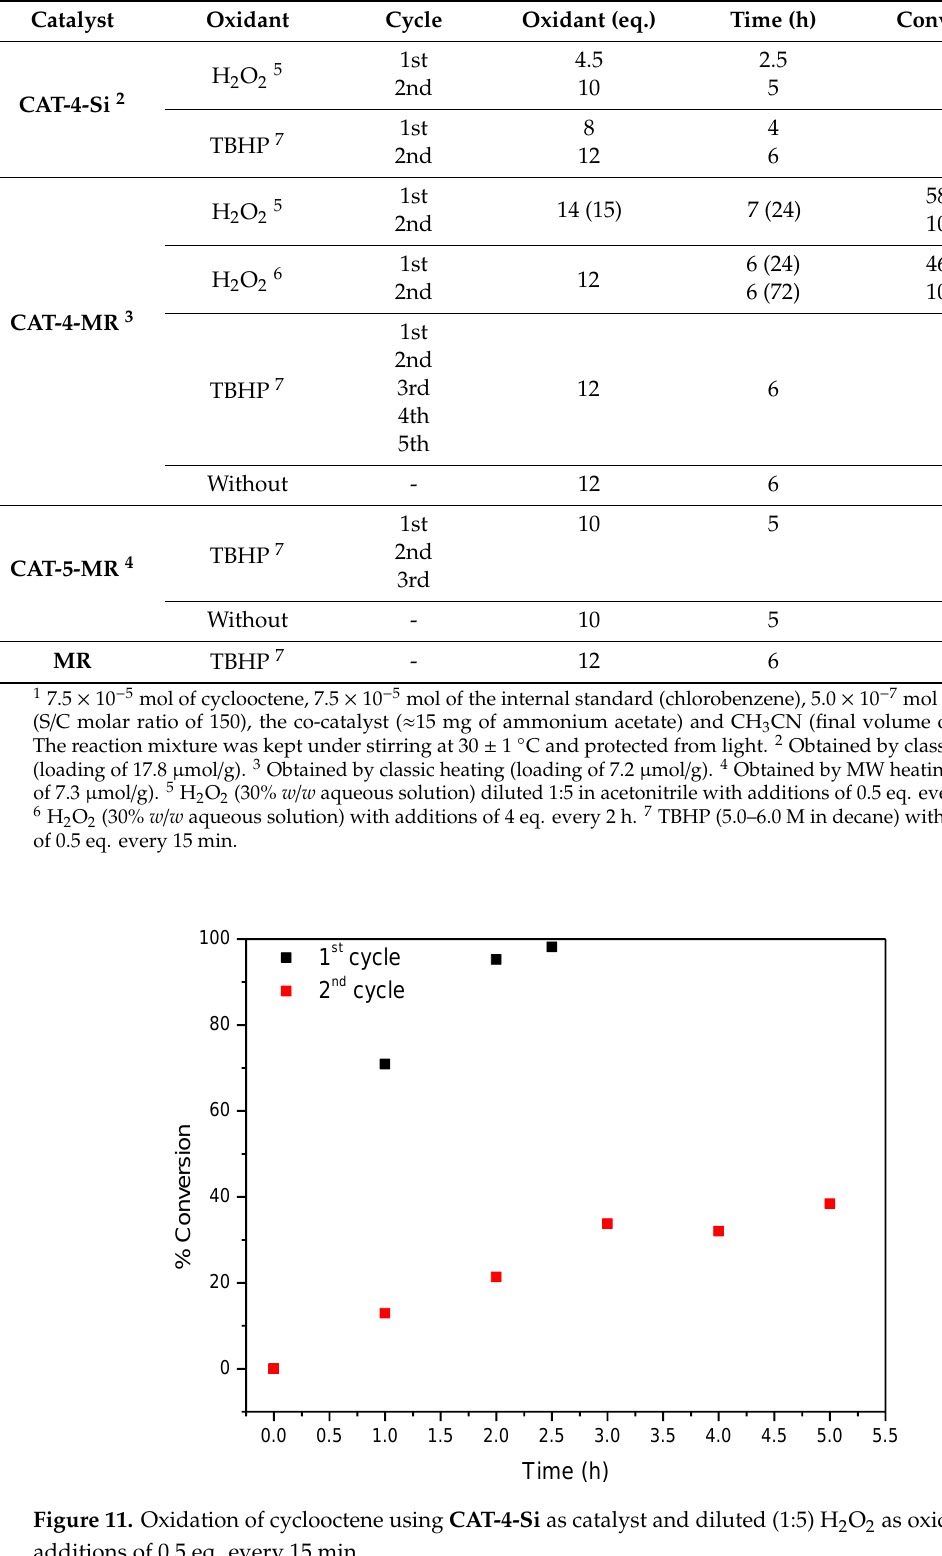
Figure 12. Oxidation of cyclooctene using CAT-4-Si as catalyst and TBHP as oxidant with additions of 0.5 eq. every 15 min.